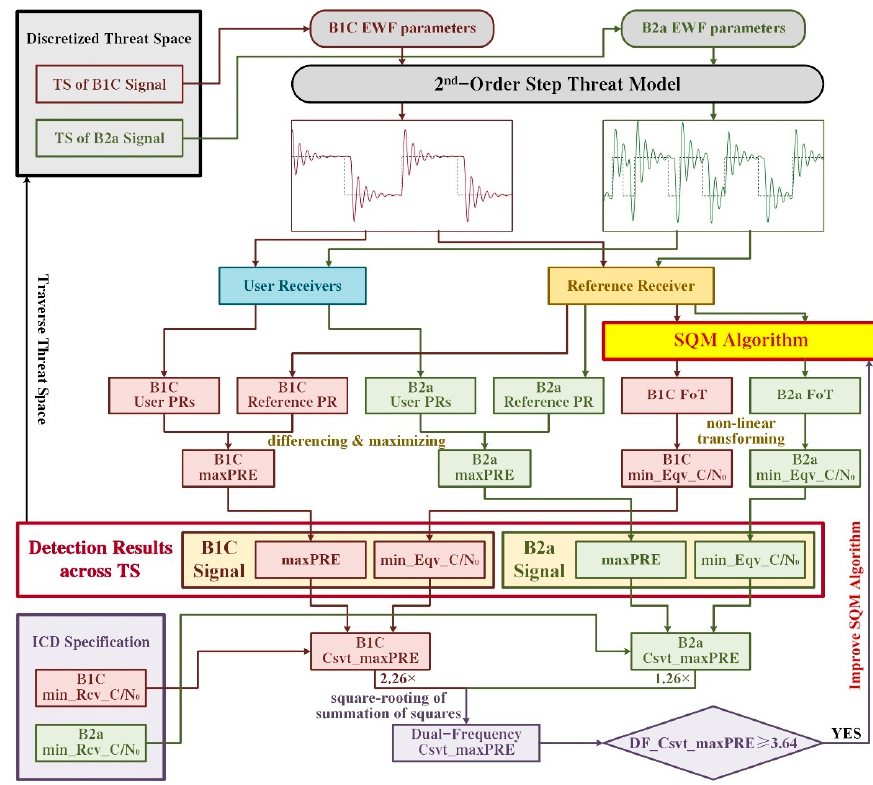
Figure 1. Design methodology of SQM algorithm for BDS B1C and B2a signals. The SQM algorithm design for BDS B1C and B2a signals operates as